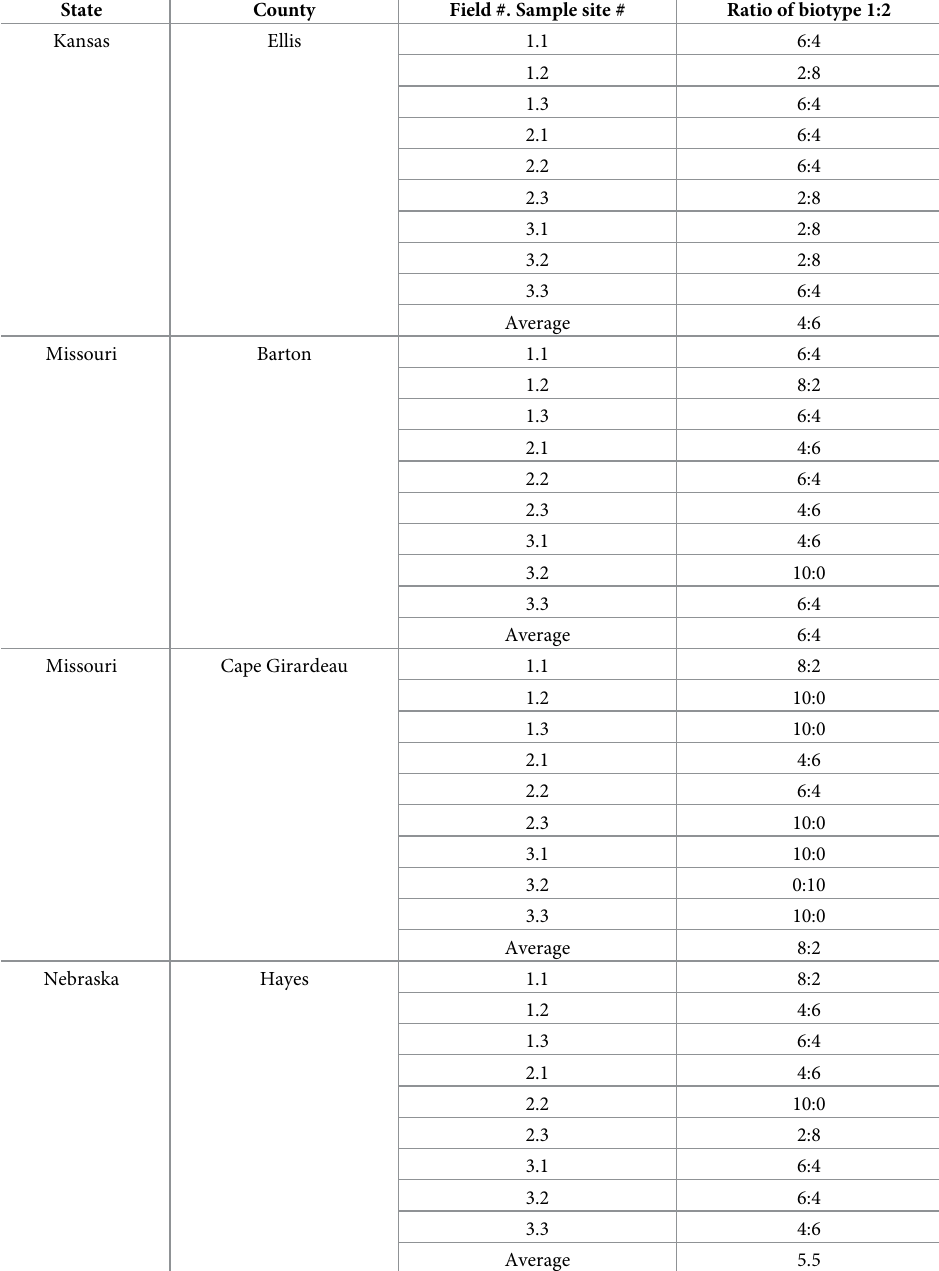
Table 2. Ratios of A . tosichella biotype 1 and 2 at one location in Kansas, two locations in Missouri, and one loca- tion in Nebraska in 2016. A total of three fields at each location were sampled, five individuals were collected at each of three sites in each field for a total of 45 individuals per